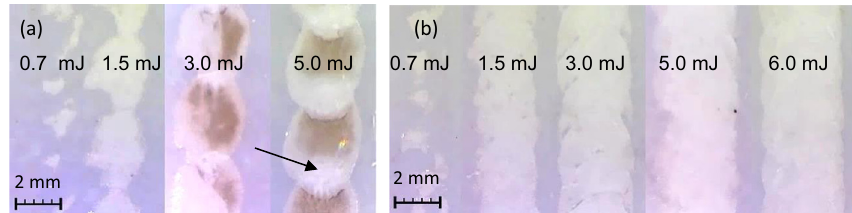
Figure 4: Ablation area of ITO on PET at di ff erent laser energies, ( a ) scanned at 1,000 mm/min and ( b ) scanned at 500 mm/min.